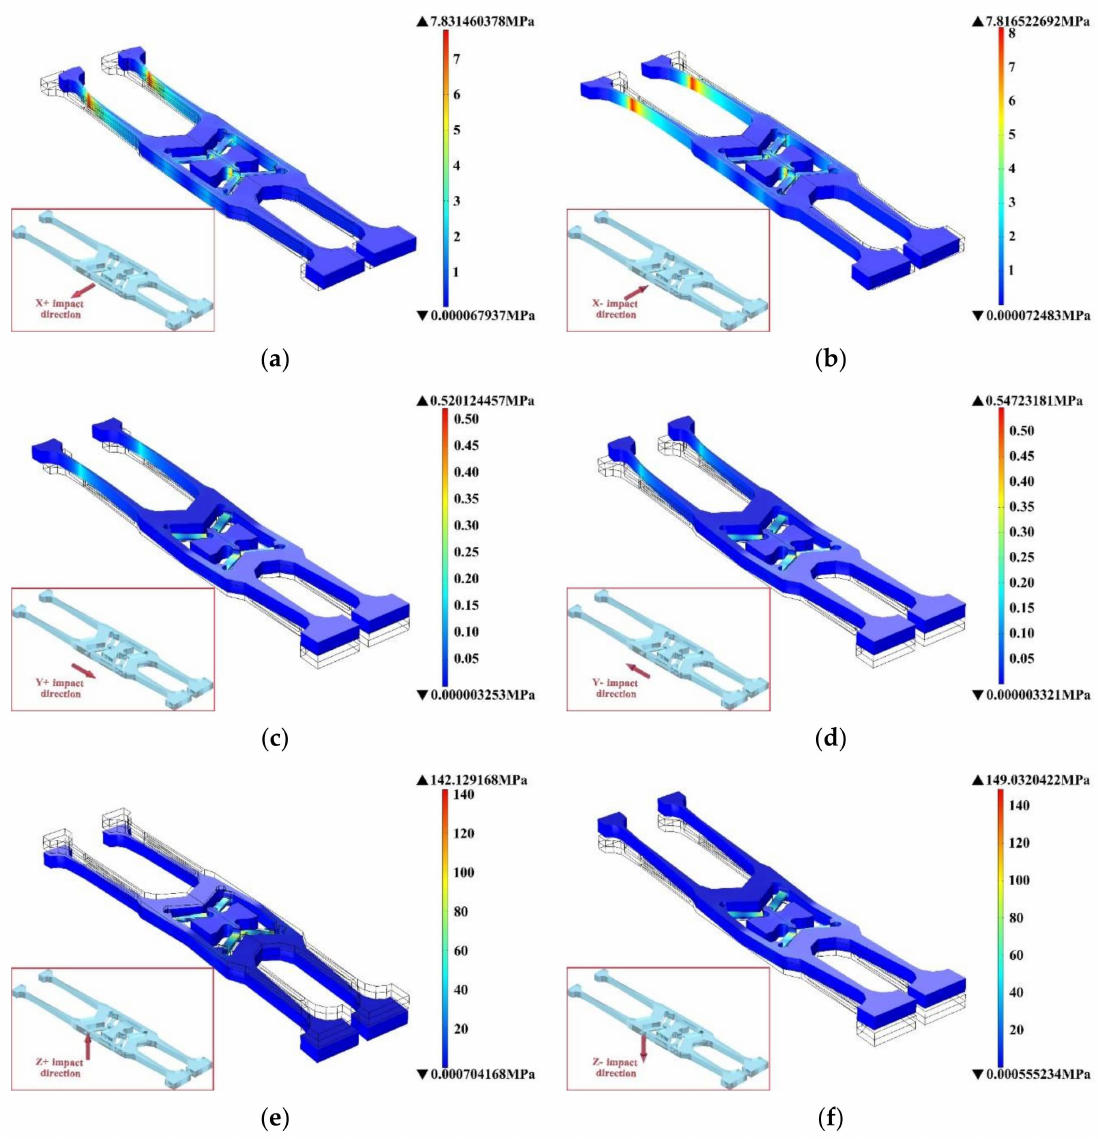
Figure 18. The stress contour with V-shaped beam thickness of 60 µ m after exerted ( a ) X + shock direction, ( b ) X − shock direction, ( c ) Y + shock direction, ( d ) Y − shock direction, ( e ) Z + shock